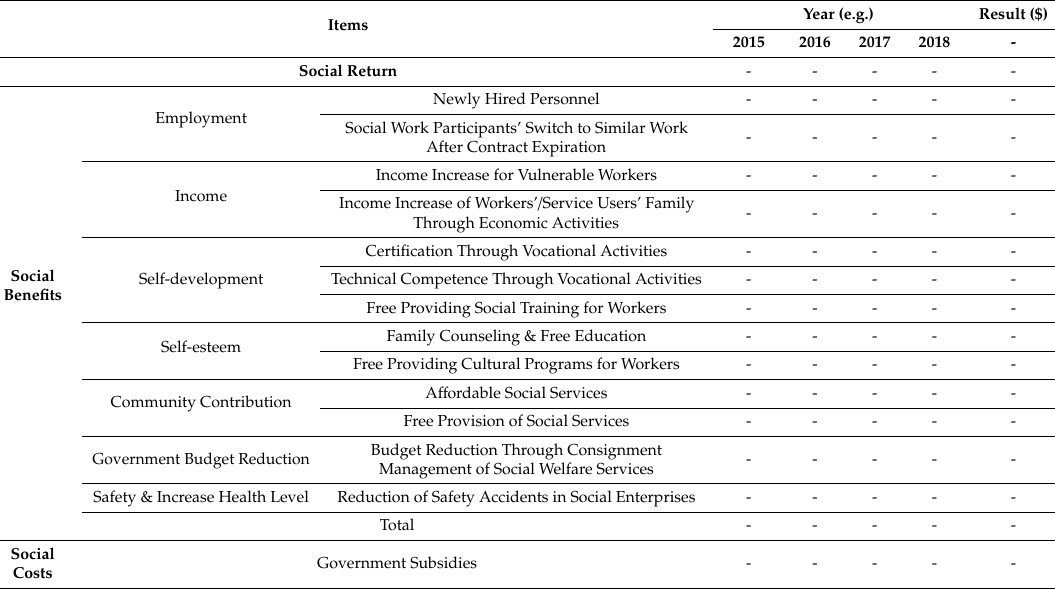
Table A3. Socio-economic Value Assessment by Year.